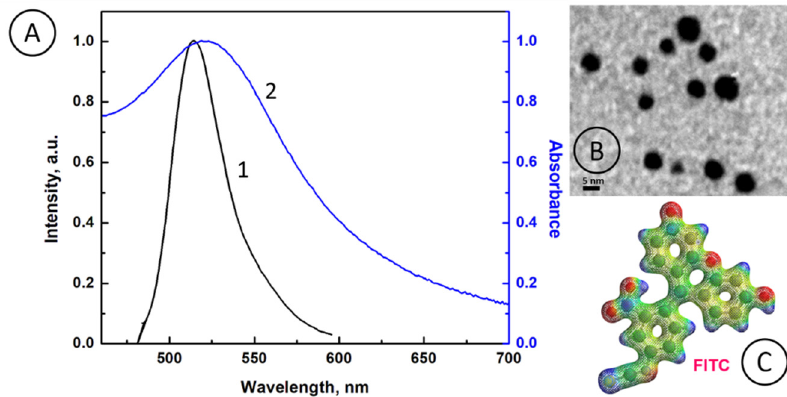
Figure 2. ( A ) Normalized fluorescence emission spectrum of FITC (1) and absorption spectrum of AuNP@Cit (2); ( B ) transmission electron microscopy (TEM) image of citrate-capped gold nanoparticles (AuNP@Cit); ( C ) The electron density surface of FITC structure with color coded electrostatic potential map (from red—more negative to blue—more positive); ρ = 0.1 au − 3 .